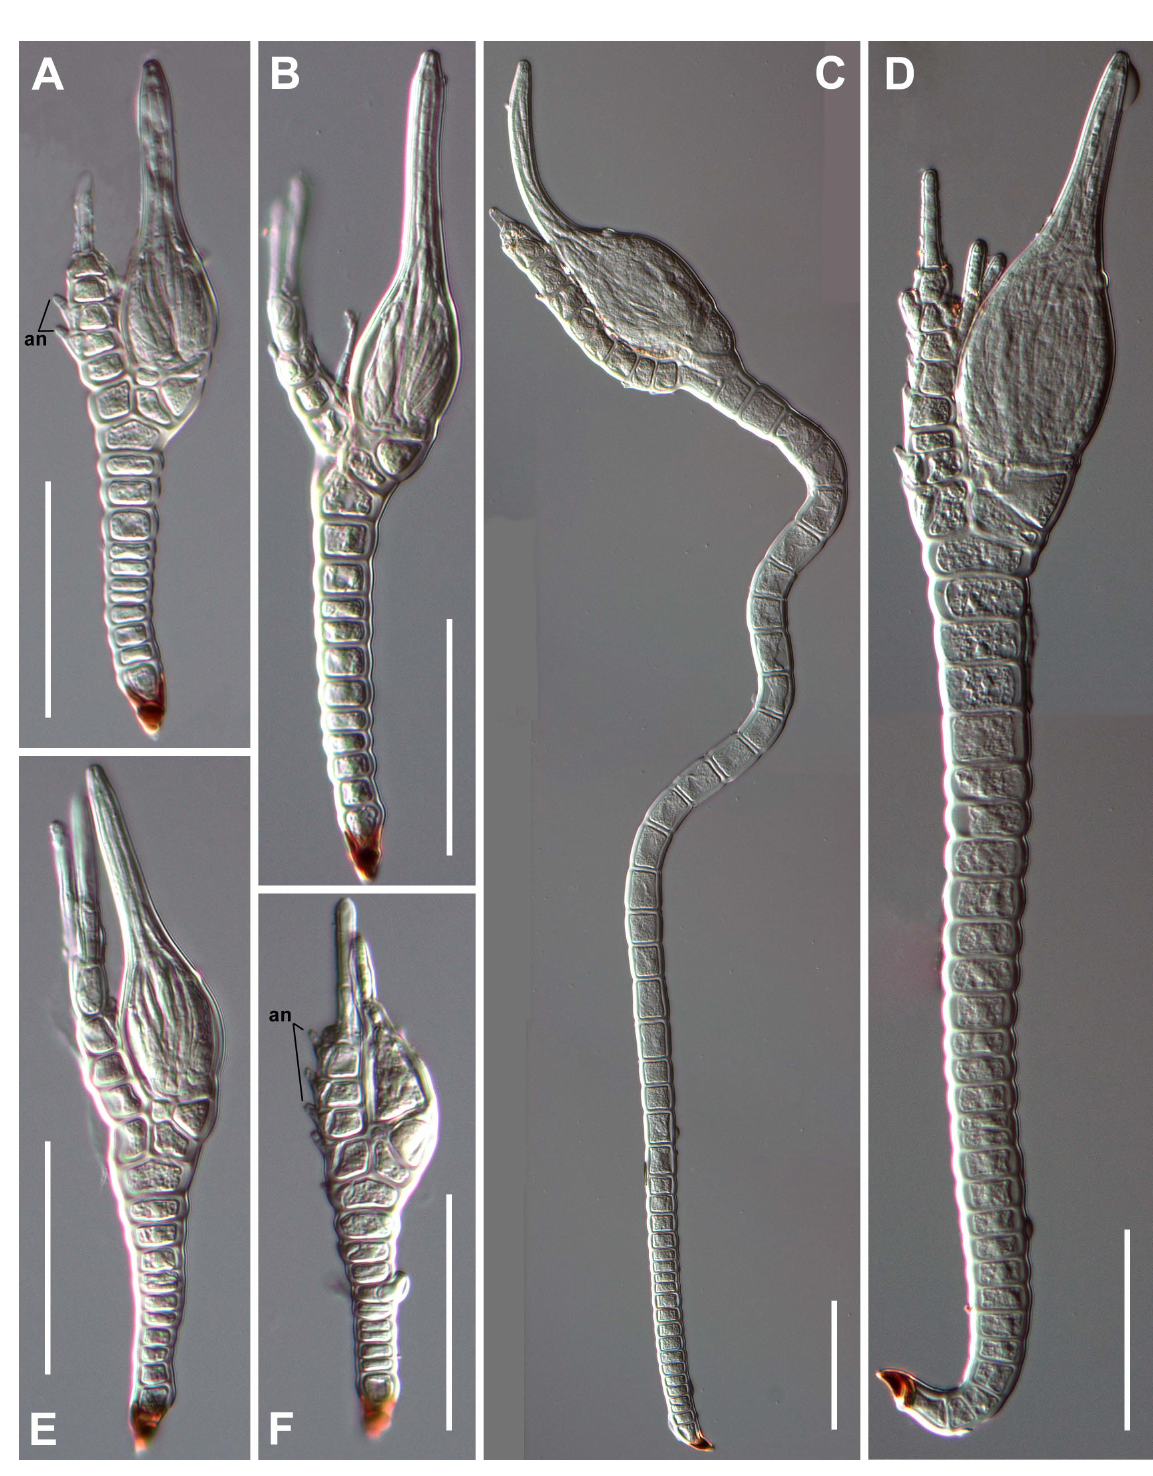
Fig. 24. Ecteinomyces trichopterophilus Thaxt. A – E . Mature thalli. In C, a very slender and flexuous thallus with up to 43 receptacular cells, and in D a gigantic thallus, both from Acrotrichis intermedia . F . Immature thallus. Antheridia (an) are labelled in A and F. Scale bars: 50 µm. Photographs from slides ZMUC C-F-122497 (A–B, E–F), ZMUC C-F-122653